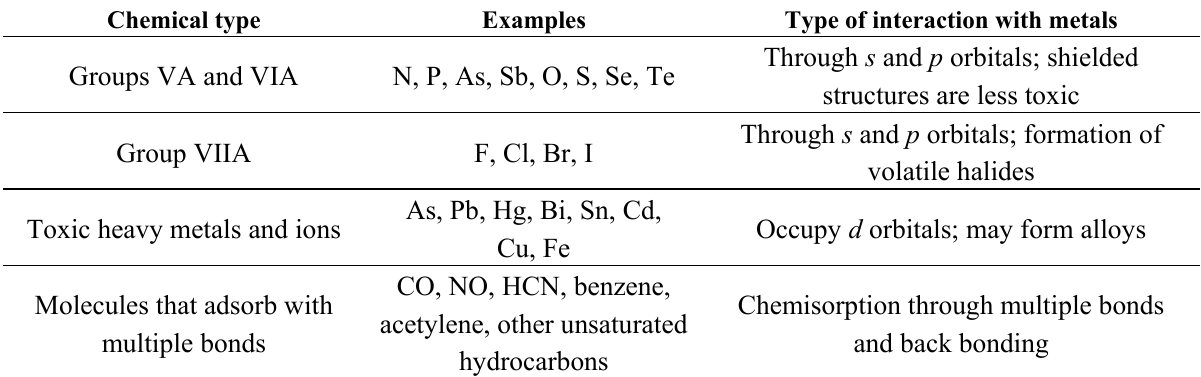
Table 2. Common poisons classified according to chemical structure.